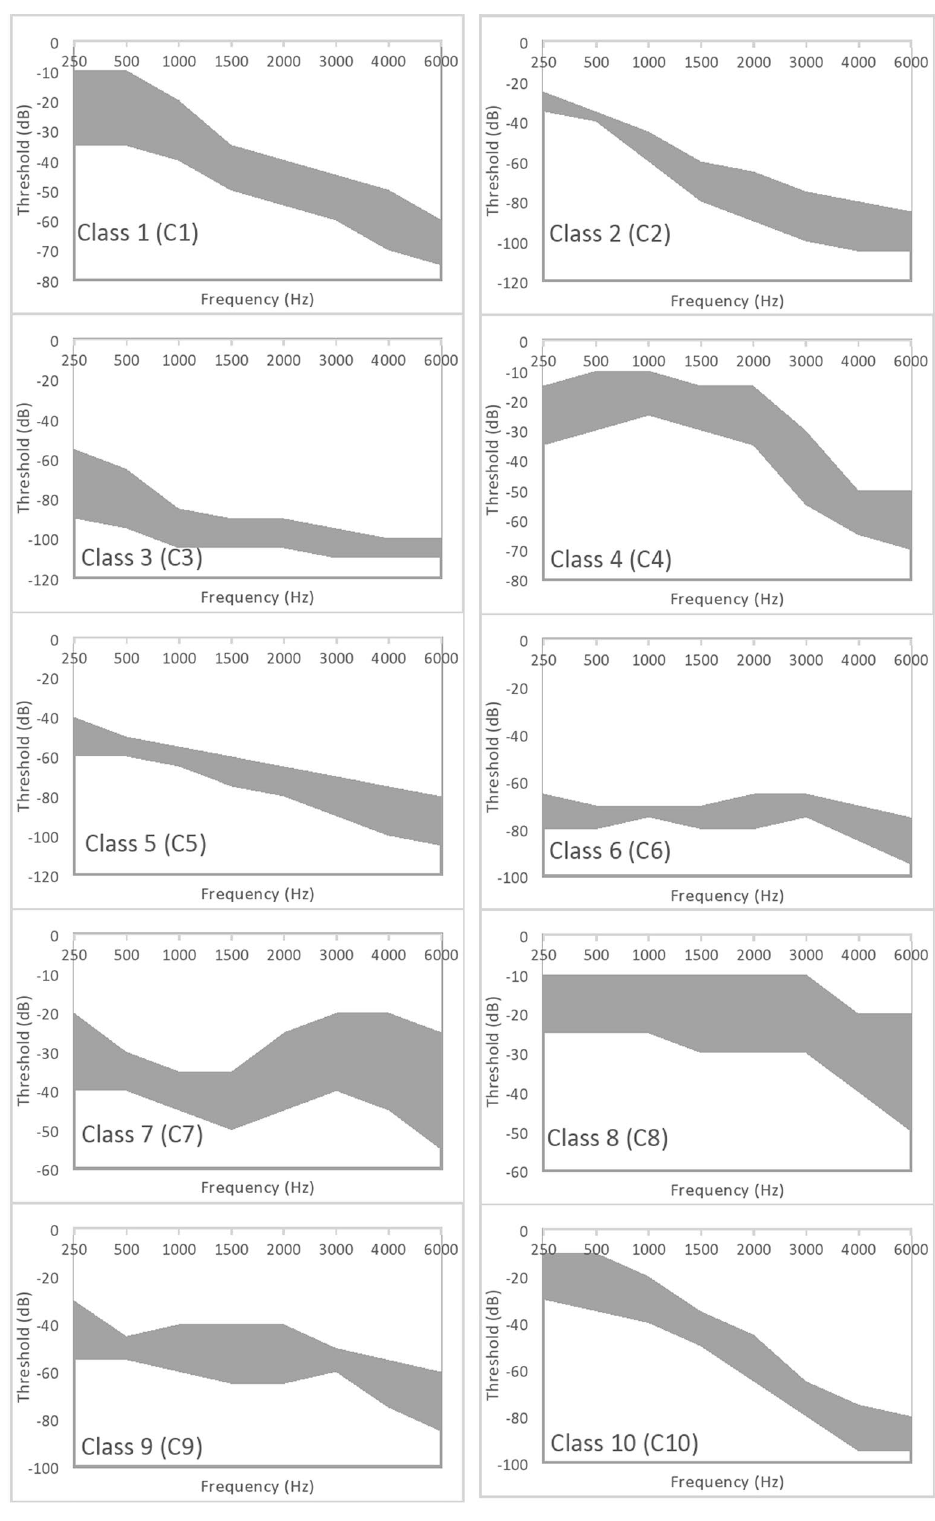
Figure 2. Audiograms clusters based on spectral clustering 15